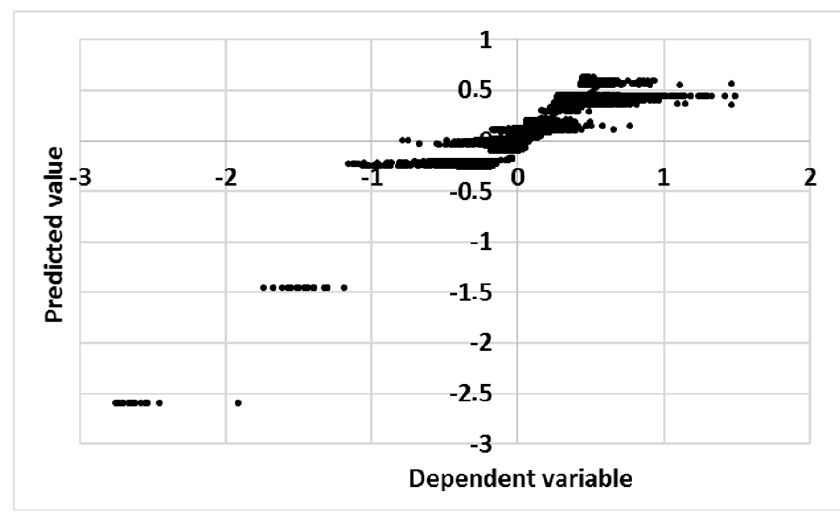
Figure 6. Predicted value versus dependent variable of the model.